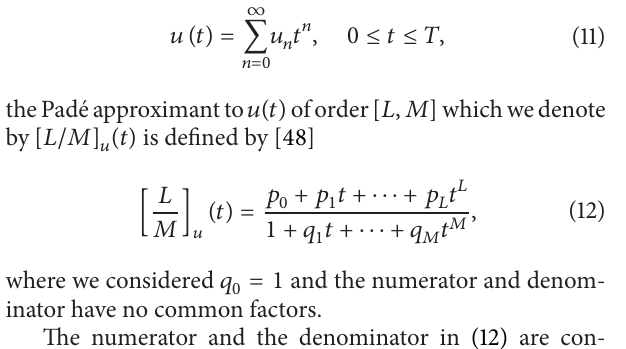
Table 1: Main operations of DTM. Function Differential